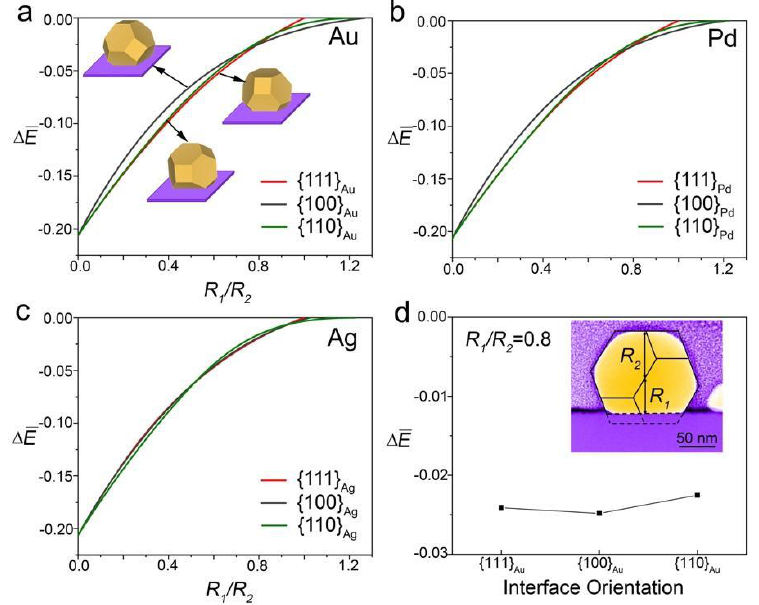
Figure 2. The change in the total energy of an FCC particle. ( a–c ) The evolution of normalized energy ∆𝐸 ̅ with R1/R2 ratio for different interface orientations for Au, Pd, and Ag, respectively. In ( a ), the morphology of differently oriented Au particles is inserted to label the different curves. ( d ) the normalized energy ∆𝐸̅ for differently oriented Au particles for a fixed R1/R2 ratio of 0.8.